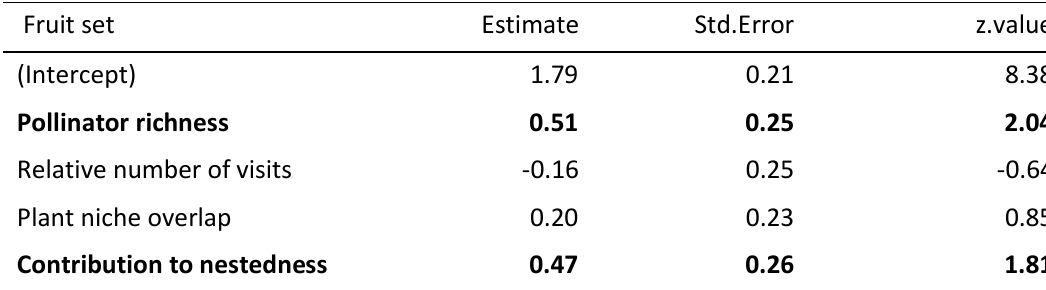
Table 1. Results of GLMM showing the association between simple visitation and network structure metrics and species-level fruit. Bold letters indicate variables with large effects (see Figure S4 for estimate confidence